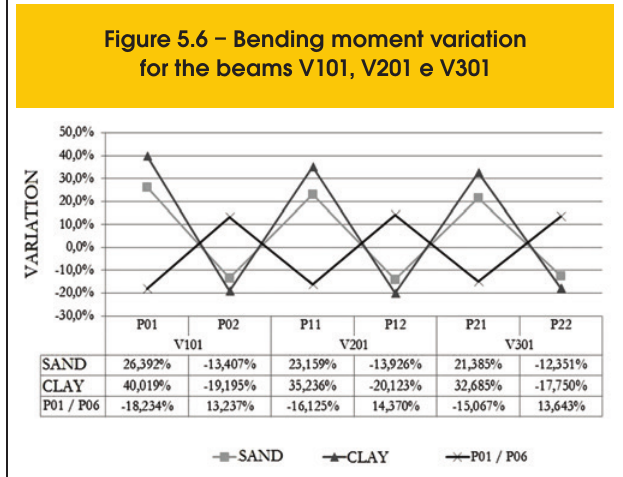
Figure 5.6 – Bending moment variation for the beams V101, V201 e